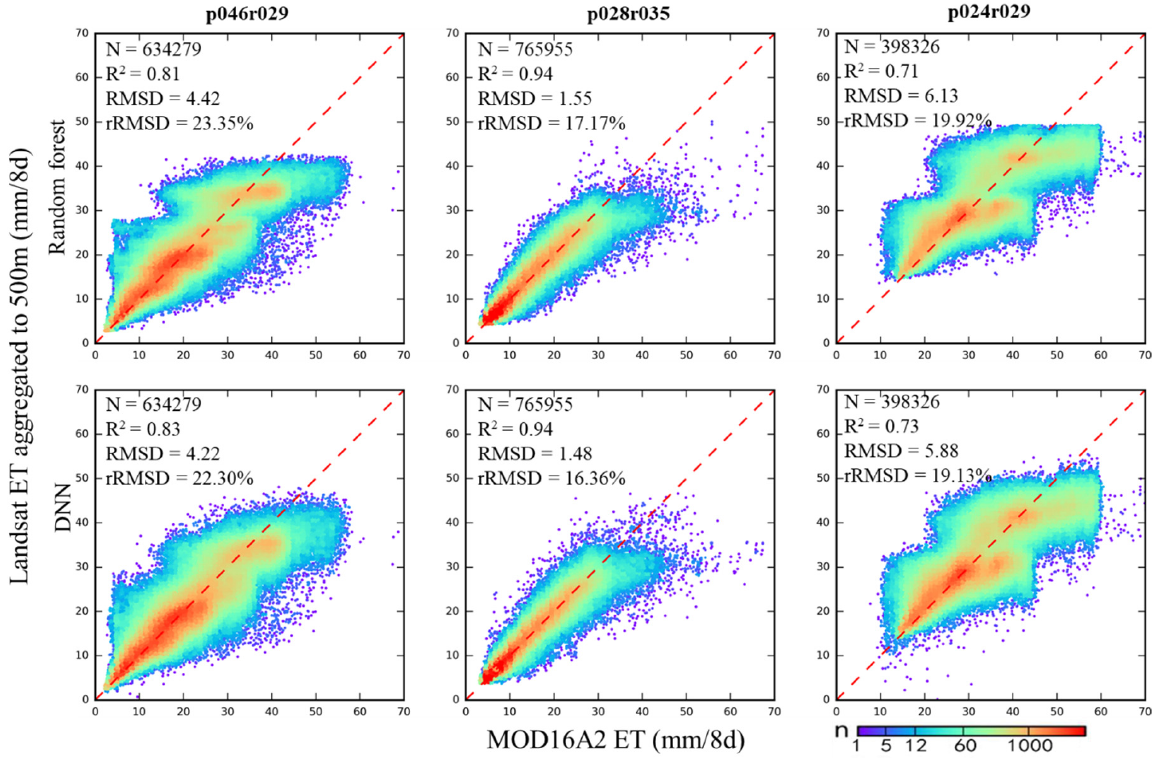
Figure 7. Scatterplots of MOD16A2 500 m good quality ET against the downscaled ET aggregated to 500 m, estimated using the random forest (top row) and the DNN model (bottom row) for three study regions. For each study region, all the Landsat images shown in Table 1 are considered.